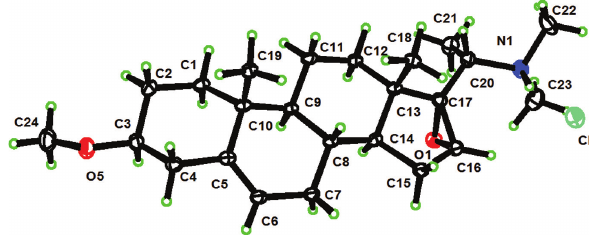
Table 1: Data collection and handling.